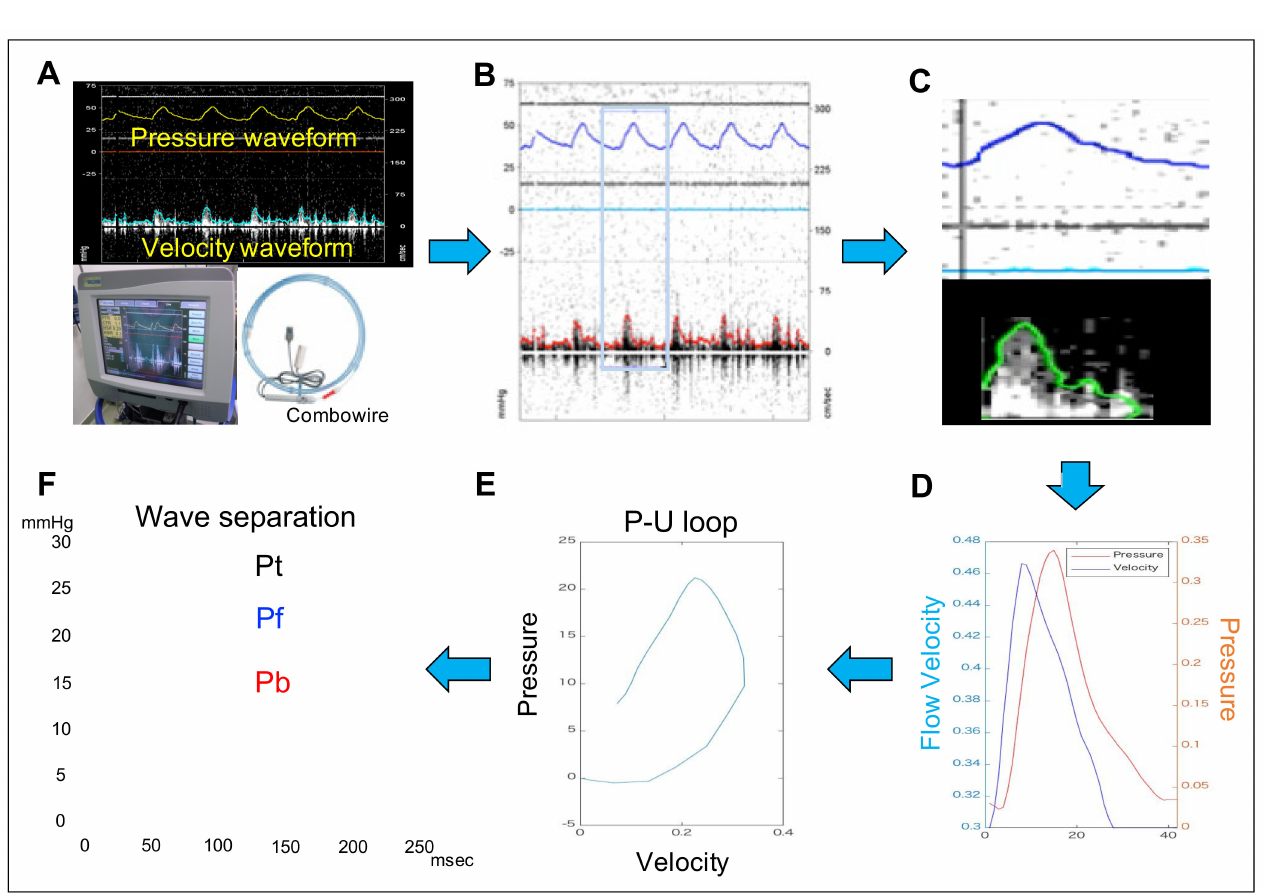
Figure 2. Illustration of the used steps for measurement of pulmonary artery wave reflection parameters. ( A ) After catheter- ization and establishment of hemodynamic, measuring the pulmonary artery flow and pressure was done simultaneously using combowire. ( B ) Detection of the cardiac cycle. ( C ) Contour detection of pressure waveform and velocity waveform. ( D ) Plotting of pressure and flow velocity. ( E ) Determination of the P-V loop. ( F ) wave